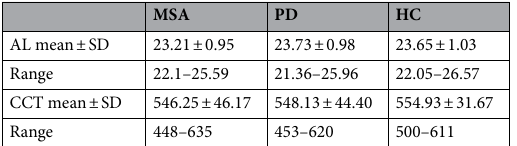
Table 5. Axial length (AL) in mm and central corneal thickness (CCT) in μm among the three